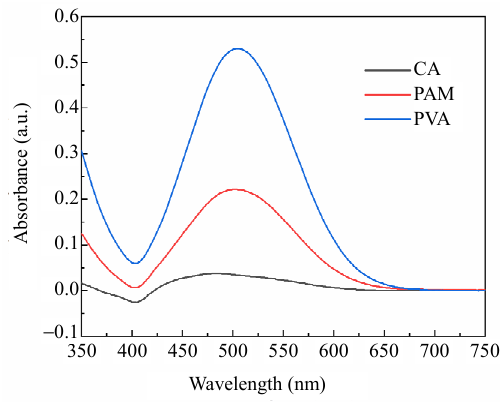
Fig. 2 Absorption spectra of pure PVA, PAM, and CA